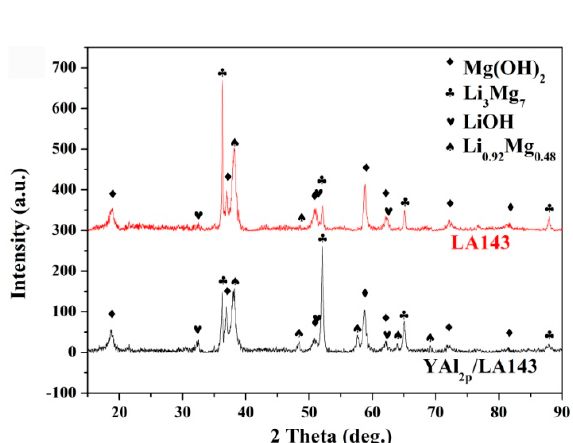
Figure 6. XRD analysis of LA143 Alloy and YAl 2p /LA143 composite, after immersion test in 3.5 wt.% NaCl solution.